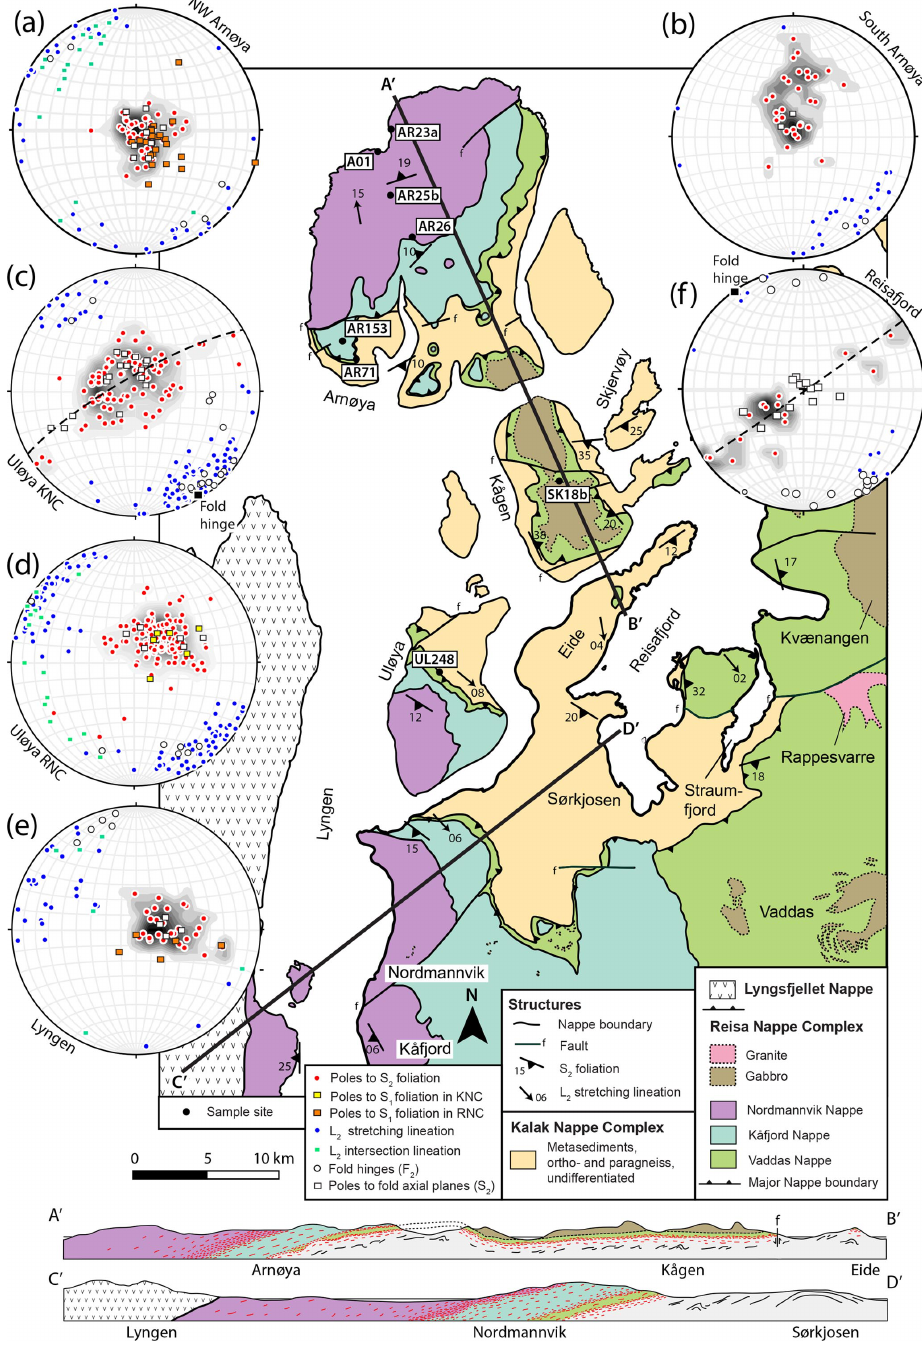
Figure 2. Structural map, stereonets, and cross sections from the study area. Petrological and geochronological sample locations are indicated. Structures are shown on equal area lower hemisphere stereographic projections as follows: (a) the RNC on northern and western Arnøya, (b) the RNC on southernmost Arnøya, (c) the KNC on Uløya; poles to S 2 plot on a great circle (dashed line), the pole of which (black box) defines a fold hinge parallel to plotted stretching lineations, (d) the RNC on Uløya, (e) the Nordmannvik Nappe on the eastern coast of Lyngen, and (f) the Vaddas Nappe on the eastern side of Reisafjord; poles to foliation define a folding event with the fold hinge (black box) parallel to the L 2 stretching lineation and measured axes of open folds. Cross sections are shown at the bottom of the figure from Arnøya to Eide (A’–B’) and from Lyngen to Sørkjosen (C’–D’) . The density of red lines corresponds to the intensity of ductile deformation within and along boundaries between individual nappes. Caledonian foliations are shown in red, whereas black ones are possibly older.